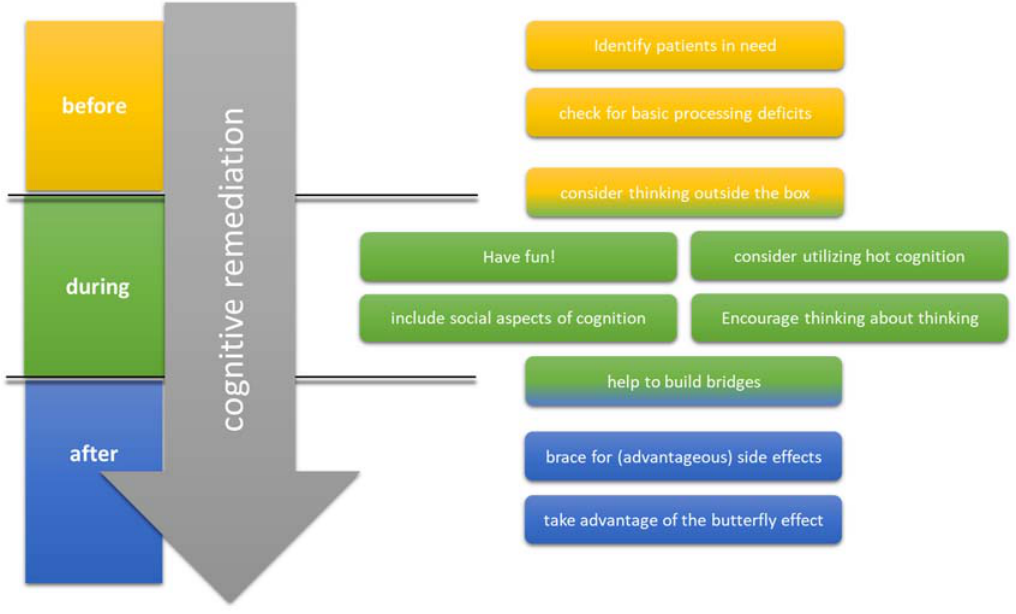
Figure 1. Strategies that could help amplify the effects of